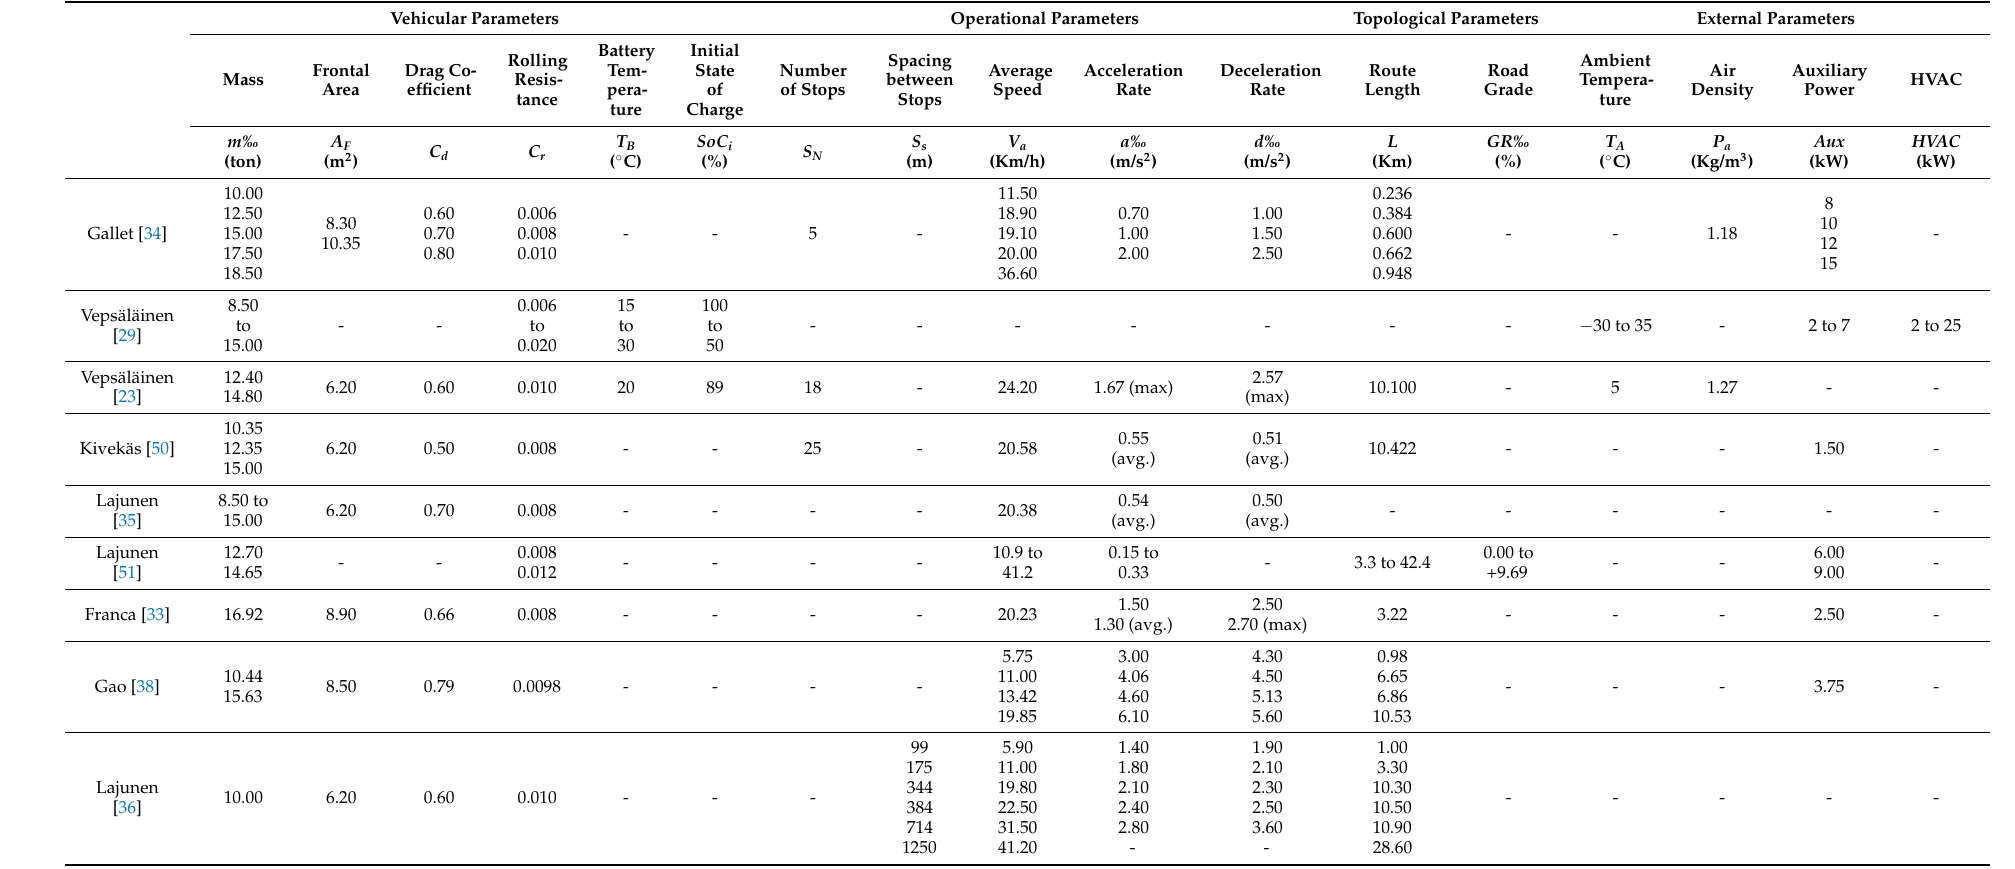
Table 1. Parameters affecting the energy consumption of BEB in the